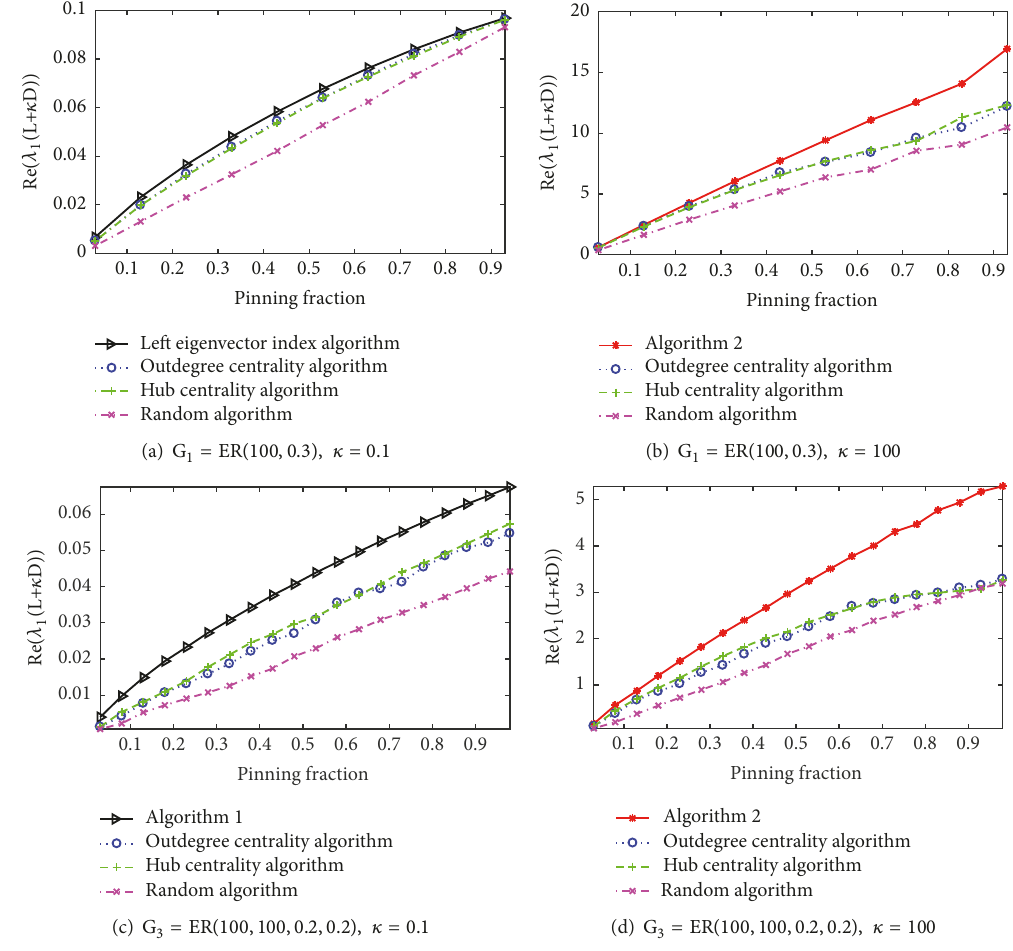
Figure 5: Variation of Re (𝜆 1 (𝐿 + 𝜅𝐷)) with respect to pinning